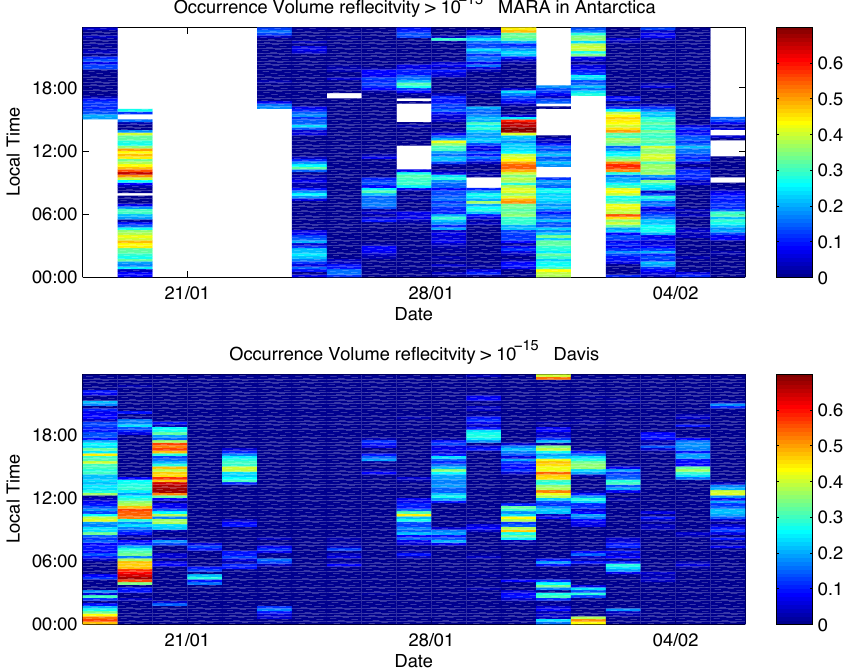
Fig. 2. Occurrence frequency of PMSE for each day for Wasa (top panel) and Davis (bottom panel). Data between 80 and 90km were used. The x-axis shows the Date and the y-axis the local solar time. Vertical bars indicates 19:00 MLT for Wasa (black) and Davis